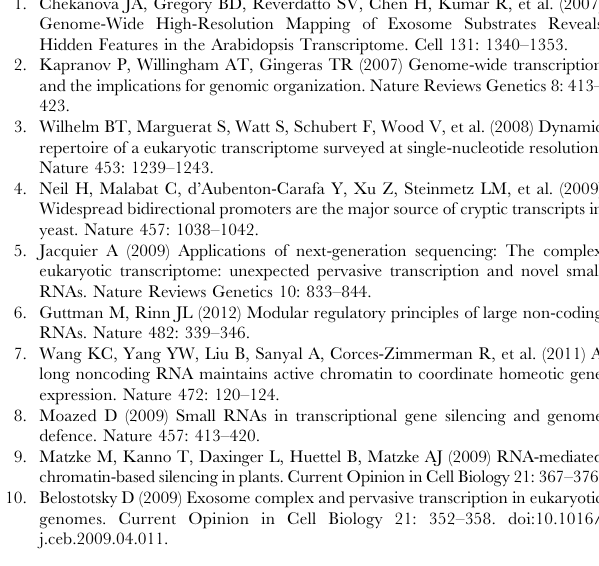
Table S1 Summary of smRNA sequence reads in the libraries of